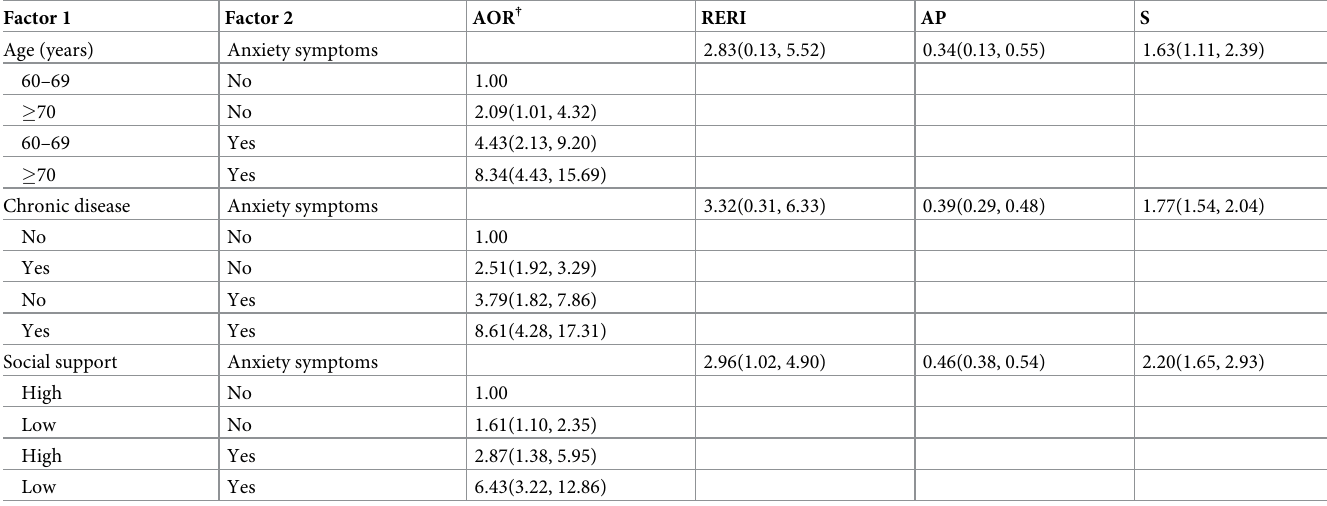
Table 5. Interactions between risk factors for poor sleep quality among the elderly in nursing